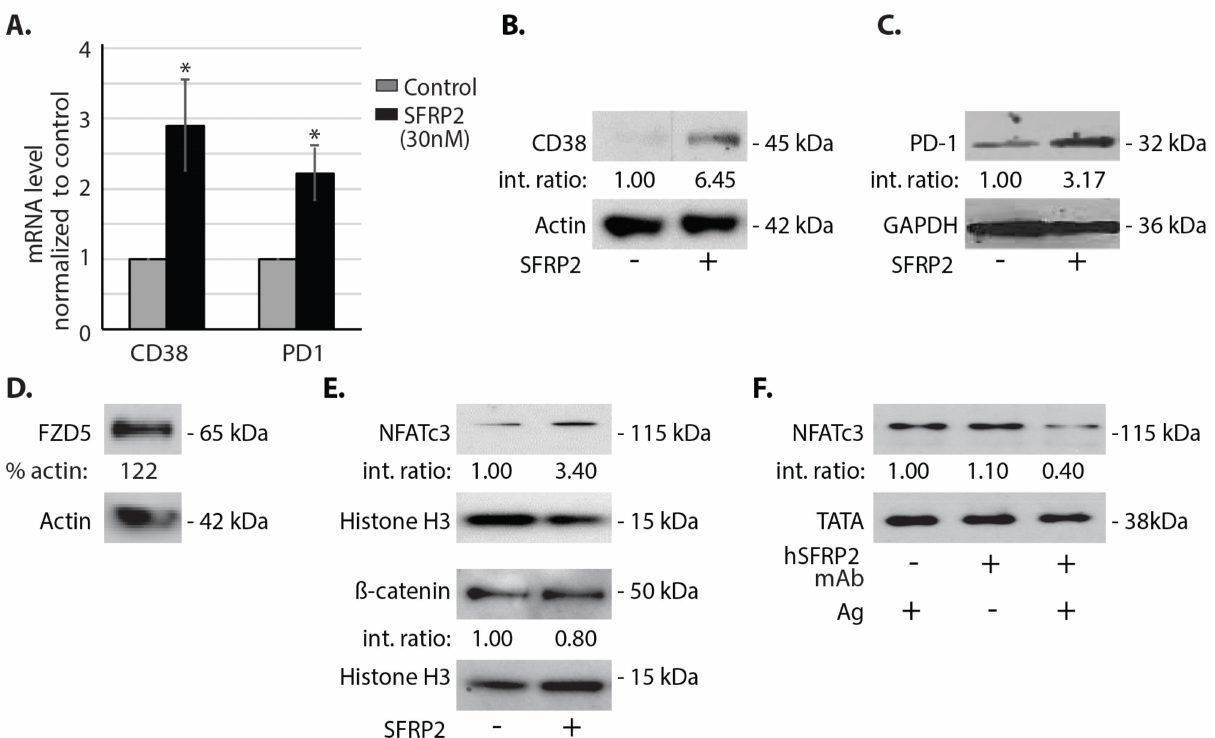
Figure 6. SFRP2 increases CD38 and PD-1 mRNA and protein levels in T-cells. ( A ) Splenic T-cells cultured in IL2-containing medium were treated with or without SFRP2 (30 nM) for 1 h, and the mRNA levels for CD38 and PD-1 were measured by qRT-PCR ( n = 8). GAPDH was used as an internal control. ( B – F ) All T-cells were treated with IL-2. Samples were probed using Western blot with antibodies to the indicated protein markers. Actin was the loading control for cytoplasmic fraction; histone H3 and TATA were loading controls for nuclear fractions. ( B , C , E , F ) Int. ratio: intensity ratios listed below Western blots for ( B – F ) were calculated after normalization to both loading control and reference samples (indicated by 1.00). ( B , C ) Cytoplasmic fractions of wild-type splenic T-cells were isolated and protein levels of CD38 ( B ) and PD-1 ( C ) were increased in SFRP2-treated T-cells, compared to untreated cells. ( D ) Western blot probing for FZD5 protein in mouse splenic T-cells. % actin: total band intensity was normalized to actin. ( E ) Splenic T-cells were untreated or treated with recombinant SFRP2 protein for 1 h. The nuclear fraction was isolated from the T-cells, and nuclear NFATc3 and β -catenin protein levels were measured. Nuclear fractions demonstrated increased NFATc3 protein levels but no change in β -catenin levels with SFRP2 treatment. ( F ) Splenic T-cells were activated with antigen gp100 (0.87 µ M) with or without 10 µ M of hSFRP2 mAb treatment. Nuclear fractions demonstrated decreased NFATc3 protein levels in hSFRP2 mAb-treated cells activated by antigen. In endothelial and tumor cells, SFRP2 binds to the FZD5 receptor and stimulates the calcineurin/NFATc3 pathway. Activated NFATc3 then translocates from the cytoplasm into is not mediated through β -catenin [15]. Whether SFRP2 utilizes a similar signaling